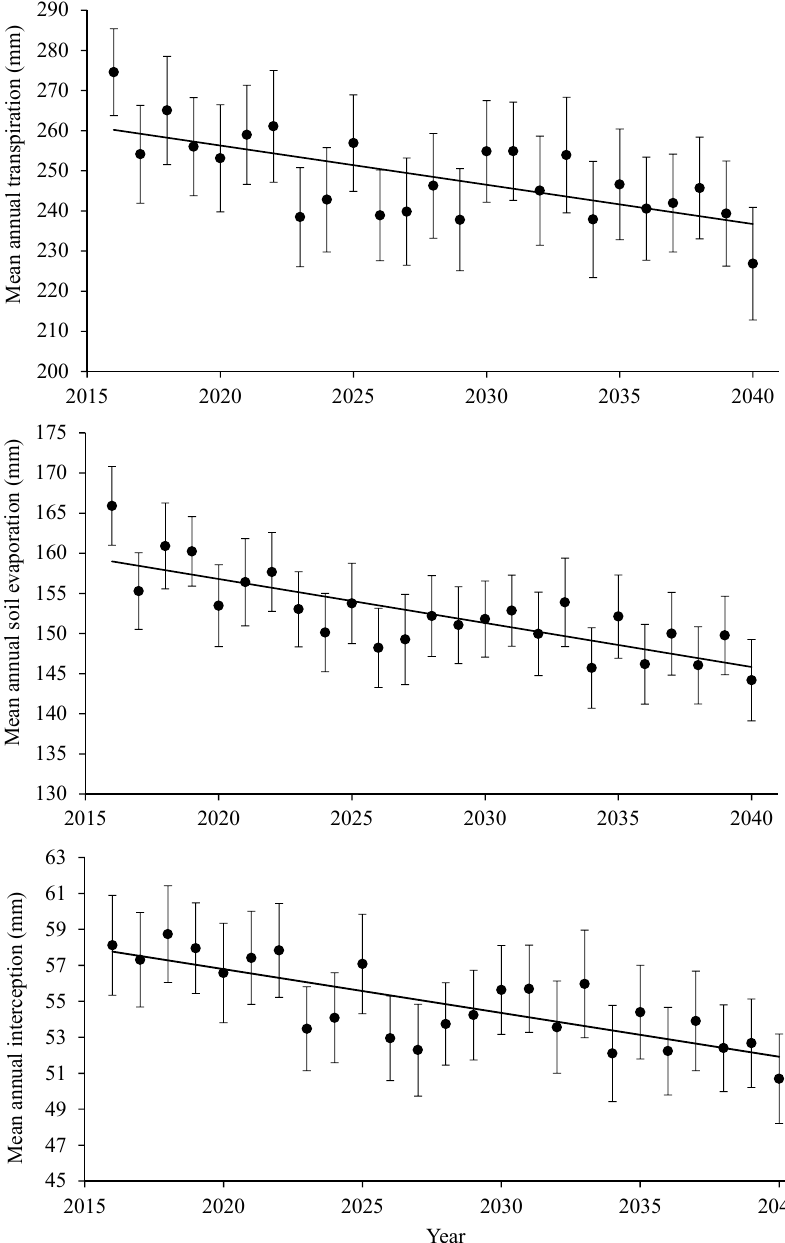
Figure 3. Mean annual actual transpiration, actual soil evaporation and interception losses with their 95% confidence levels and trendlines.